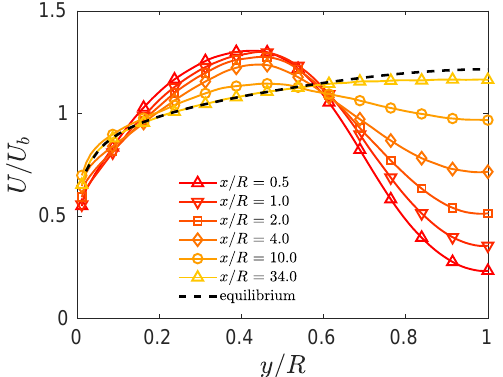
Figure 11. Development of the mean axial velocity in the wake of the streamlined body of revolution (body blockage ratio =